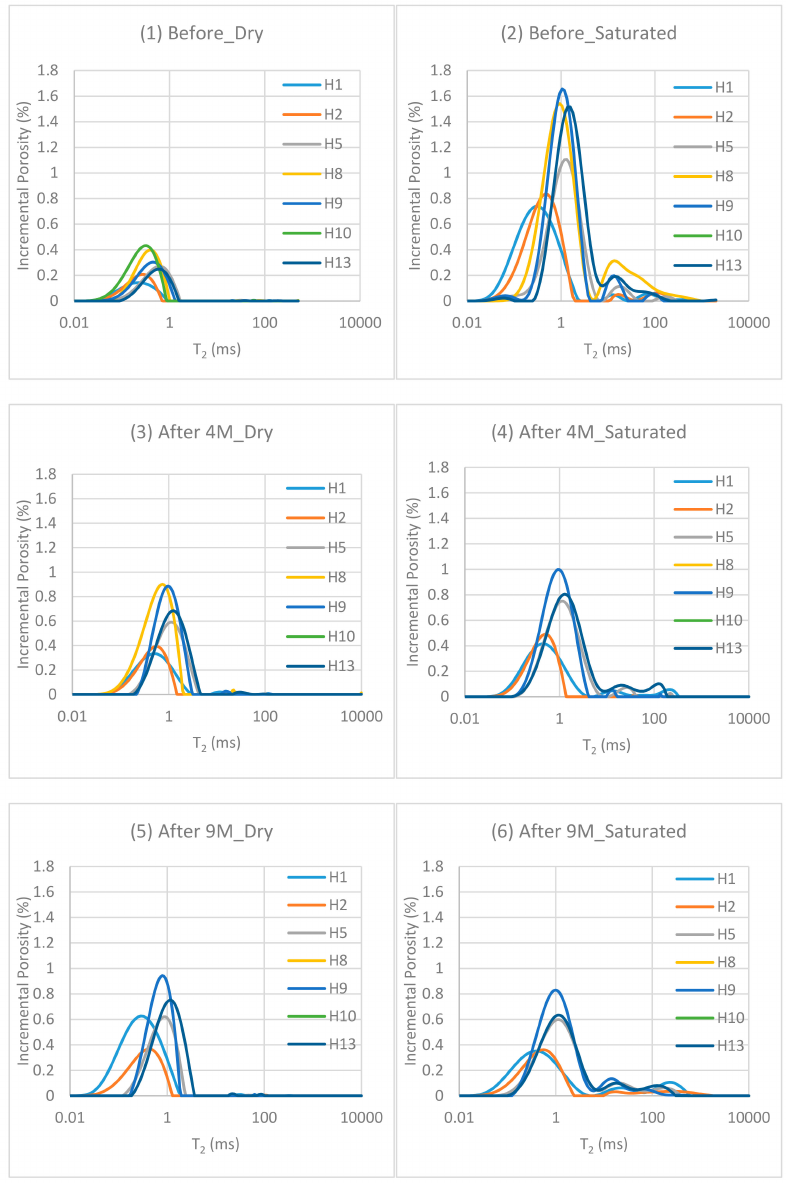
Figure 3. T 2 distribution of ( 1 ) dry state (as received samples from core store) before exposure to scCO 2 , ( 2 ) brine-saturated state before exposure to scCO 2 , ( 3 ) directly after 4 months exposure to scCO 2 , ( 4 ) brine re-saturated state after exposure to scCO 2 , ( 5 ) directly after 9 months exposure to scCO 2 , ( 6 ) brine re-saturated state after 9 months exposure to scCO 2 . Sample H10 failed after first saturation and sample H8 failed after second